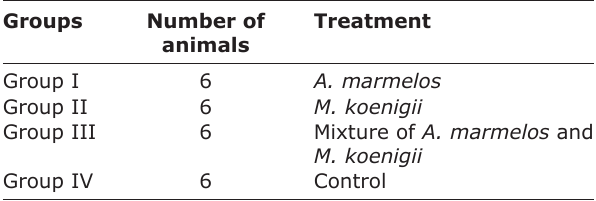
Table-1: Treatment